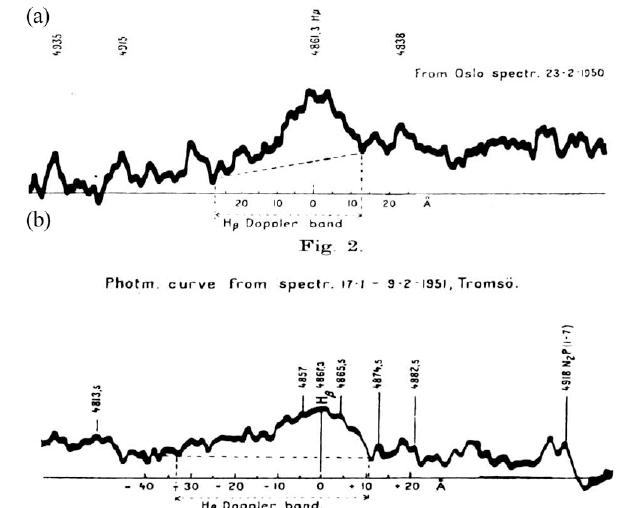
Figure 2. This figure shows hydrogen northern-light emissions, ob- served about a year apart, at Oslo (a) and Tromsø (b) .